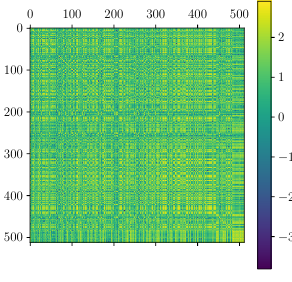
(b) Estimated covariance matrix (in log scale) computed on 512 tuples of interest.